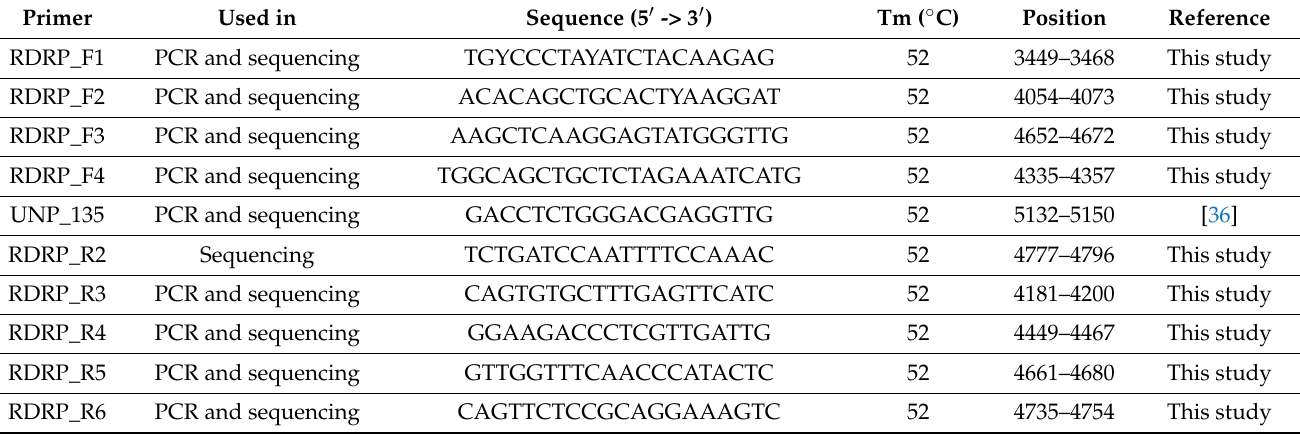
Table 3. Primer sequences used for PCR reactions and Sanger sequencing of the complete RdRp